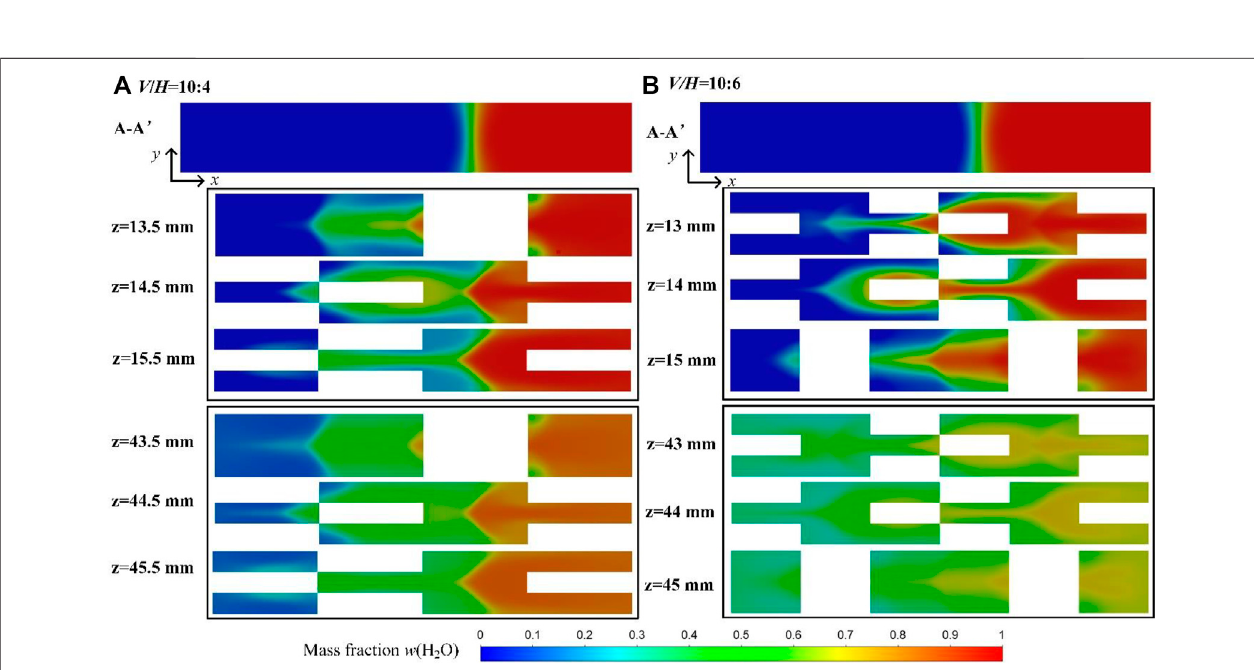
FIGURE 14 | Concentration distribution of water on x-y planes with different ratios of V / H at R e (cid:1) 2 ( s / l (cid:1) 2:1, V (cid:1) 10 mm, l (cid:1) 1 mm): (A) V / H (cid:1) 10:4 and (B) V / H (cid:1) 10:6.